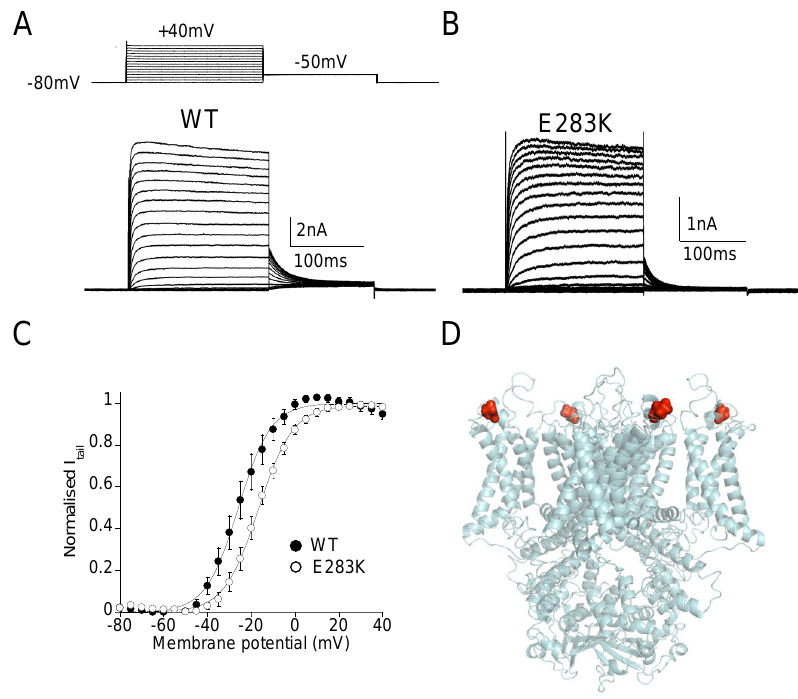
Figure 2. ( A , B ) Representative current traces evoked by 200 ms depolarizing steps ( ∆ V + 5 mV) from a holding potential of − 80 mV to 40 mV, followed by a 150 ms step at − 50 mV (inset) from Kv1.1WT and Kv1.1E283K channels expressed in HEK 293 cells (panels A and B , respectively). Kv1.1E283K channels activate more slowly than Kv1.1WT channels ( τ at V 1 / 2 is 5.2 ± 0.2 ms and 11.7 ± 0.6 ms, for WT and E283K channels, respectively), and produce smaller currents. ( C ) The current-voltage relationships for Kv1.1WT and Kv1.1E283K channels were obtained by plotting the normalized peak tail currents measured at − 50 mV as a function of the pre-pulse potentials and fitting data points with a Boltzmann function (V 1 / 2 is − 25.8 ± 0.4 mV and − 16.5 ± 0.3 mV, for WT and E283K channels, respectively; slope factor is 7.4 ± 0.4 mV and 7.8 ± 0.2 mV, for WT and E283K channels, respectively. ( D ) Homology model of the mutant Kv1.1E283K, built upon the Kv1.2 crystal structure (PDB code: 3LUT), showing the localization of the E283K mutation (red dots). A thorough characterization of Kv1.1E283K channels has been provided in